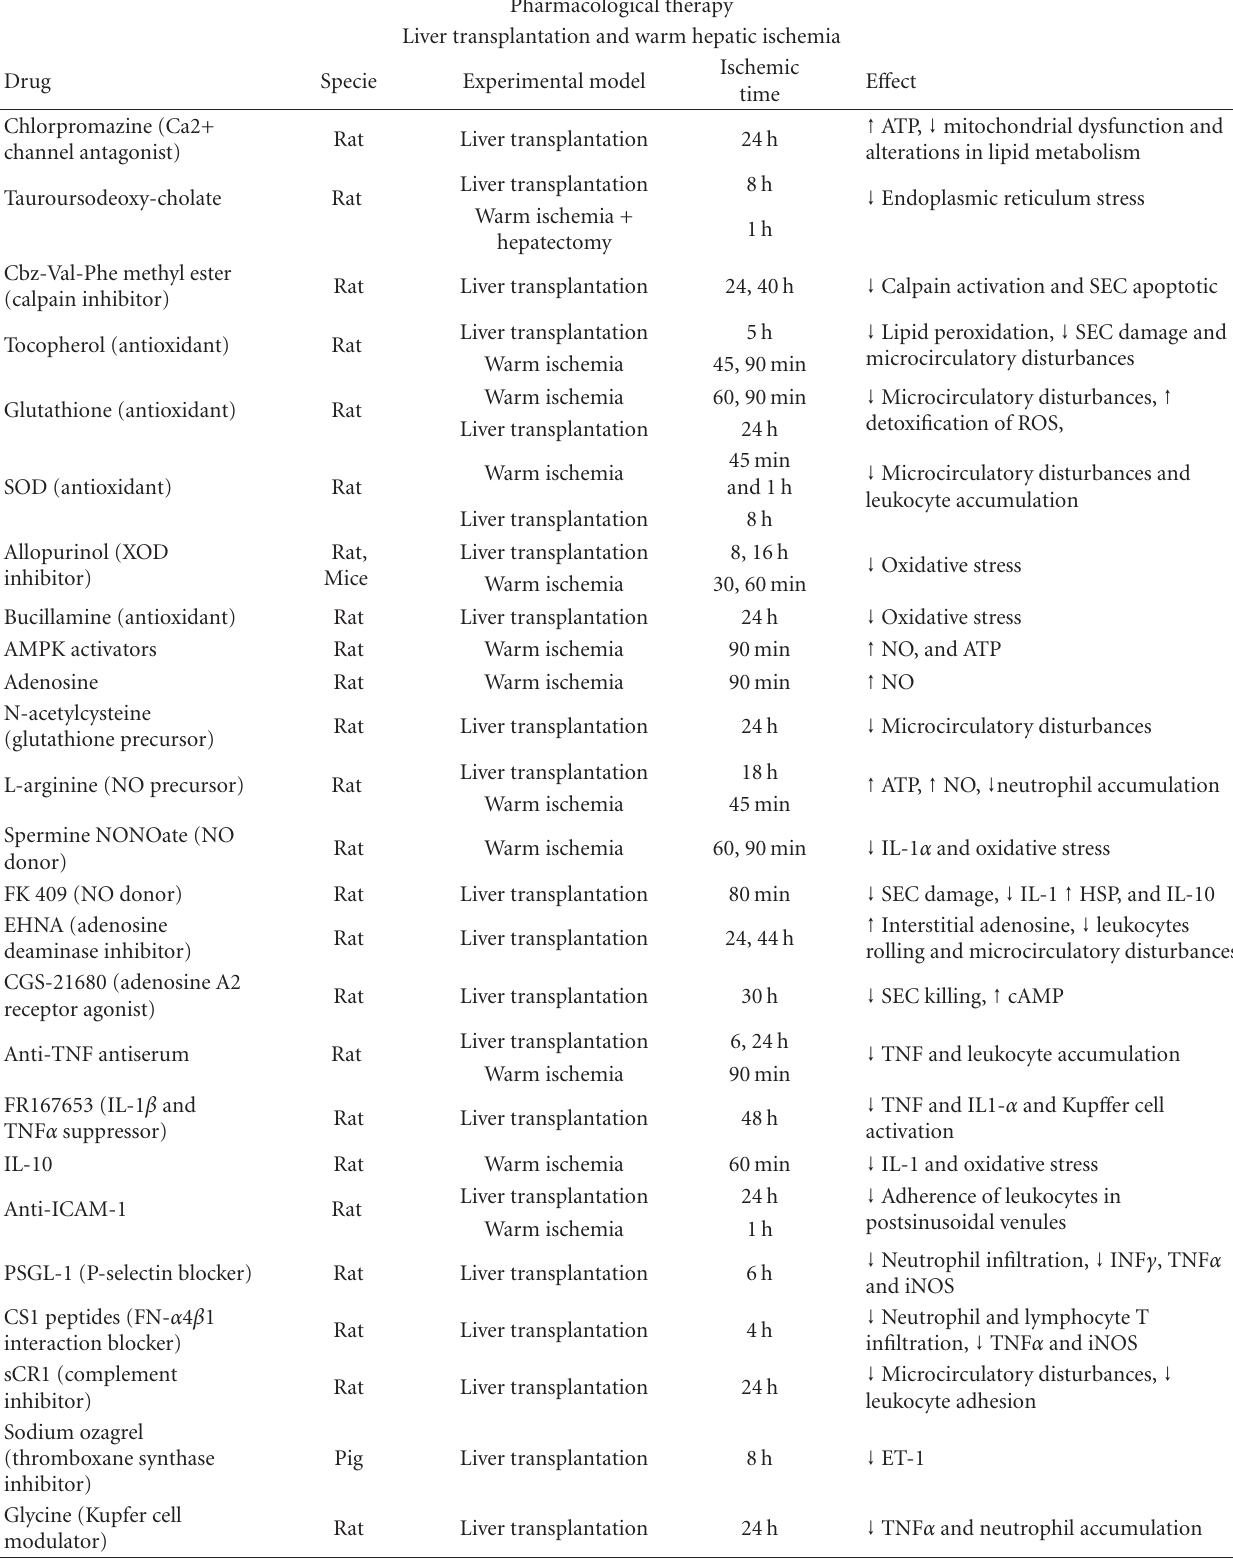
Table 1: Pharmacological treatments to protect liver against ischemia/reperfusion. AMP; activated protein kinase, AMPK; heme oxygenase- 1, HO-1; interleukin, IL; nitric oxide, NO; peroxisome proliferator-activated receptor- α , PPAR- α ; peroxisome proliferator-activated receptor (PPAR) γ , PPAR- γ ; reactive oxygen species, ROS; tumour necrosis factor TNF;. xanthine dehydrogenase/xanthine oxidase,